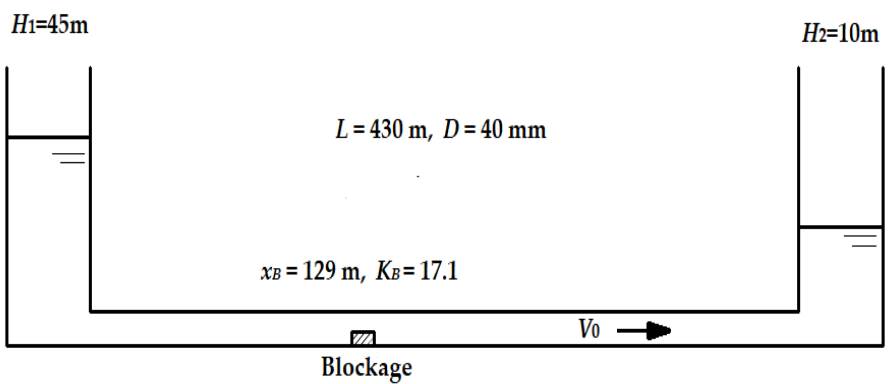
Figure 7. Simplified diagram of the test bench.